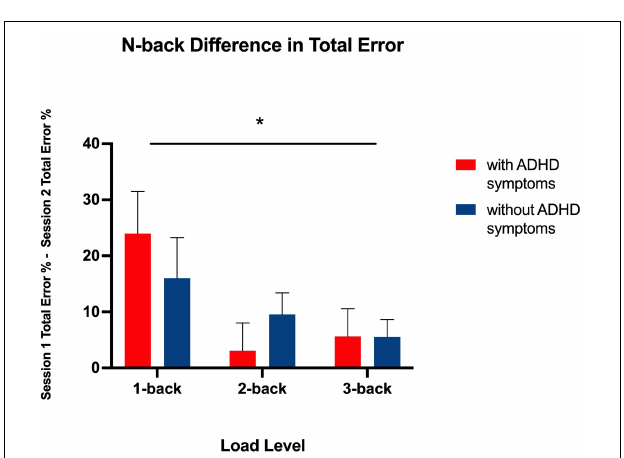
FIGURE 3 | Bar graph showing total error difference scores between Session 1 and 2 for each N-back level in both groups. * indicates a significant main effect of N-back level, p < 0.05, two-tailed. This shows a chronotype dependent effect on performance for all